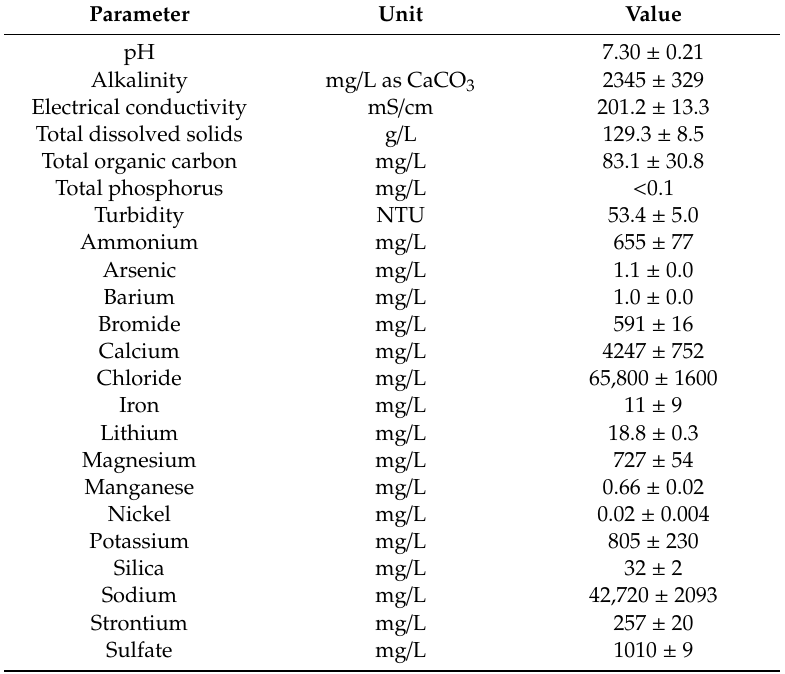
Table 2. Chemical characteristics of the produced water from the Permian Basin, Jal,